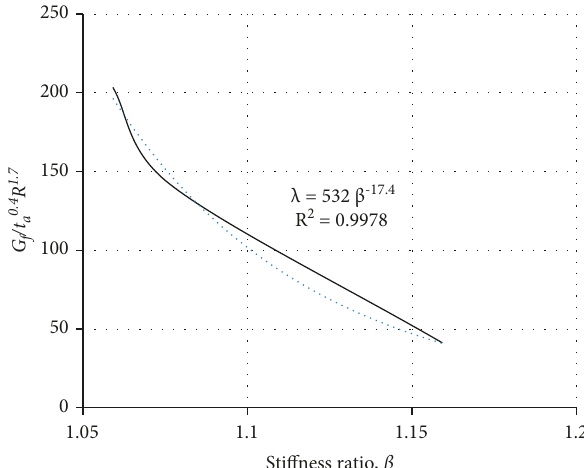
f ) and stiffness ratio